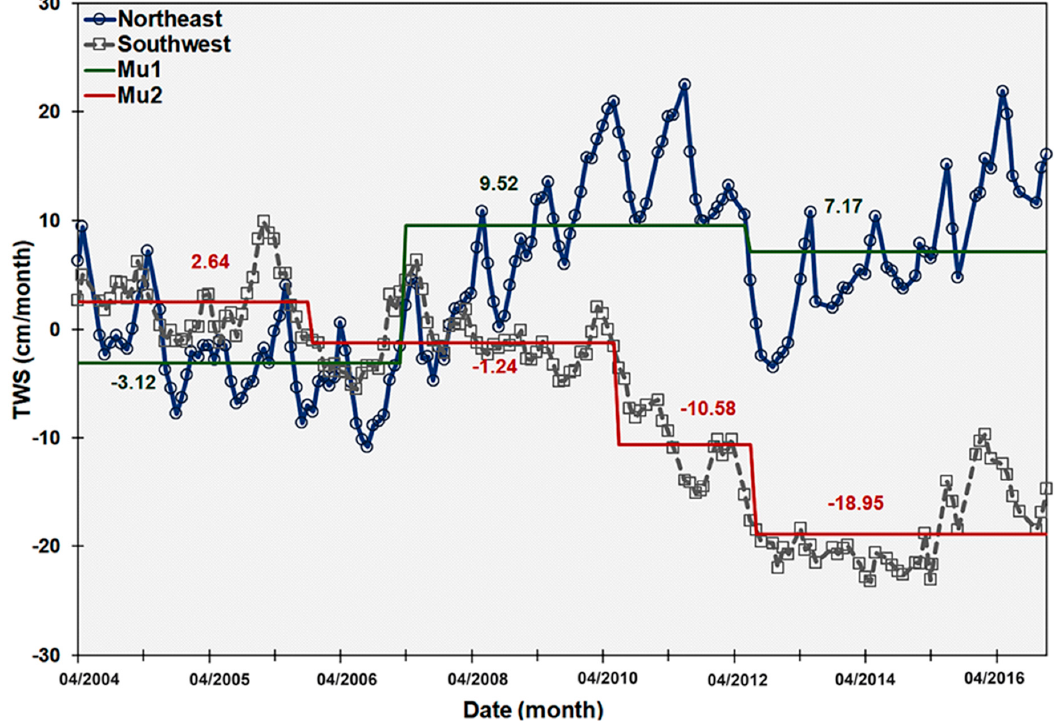
Figure 7. Temporal variability of TWS from 2002–2017 in two hotspot areas (northeast and southwest). Changes in Mu1 and Mu2 indicate regime-shifts in the TWS patterns over the two regions.